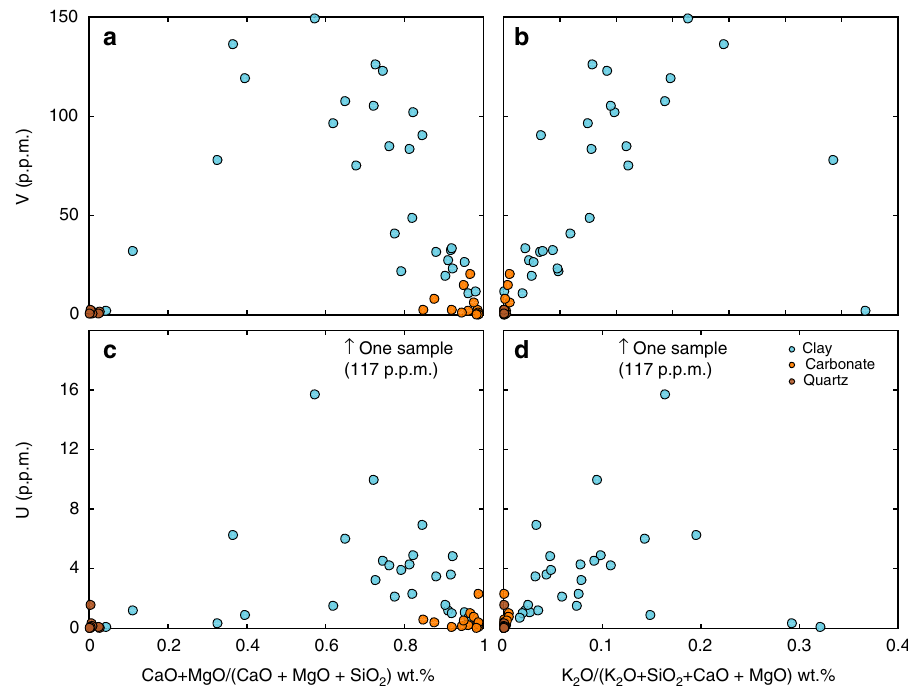
Fig. 4 Laser ablation results showing TE are contained in clay. Laser ablation ICP-MS analyses of carbonate-, clay-, and quartz-rich locations from all sampled sections. Clay-rich fractions contain the majority of trace elements, shown clearly for V ( a , b ), both when plotted against proportion carbonate (CaO + MgO/(CaO + MgO+ SiO 2 )) or against proportion K 2 O, which will be highest in clays. Although the relationship is less clear for U ( c , d ) it is still found predominately in clay. Since clay minerals contain most of the TEs, we suggest the TE signal directly re fl ects ocean water oxygen concentrations, and not a detrital